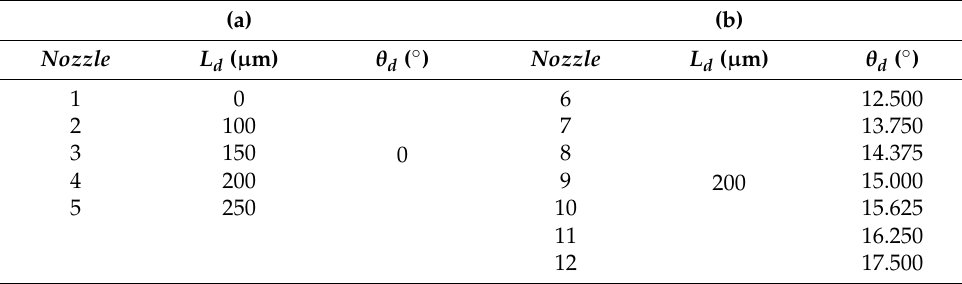
Table 3. The variants of the nozzle orifice